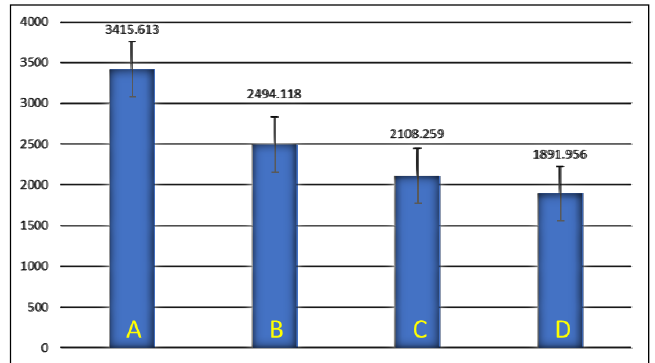
Figure 3. Mean values of maximum load to fracture expressed in newtons (N). A, Group A; B,